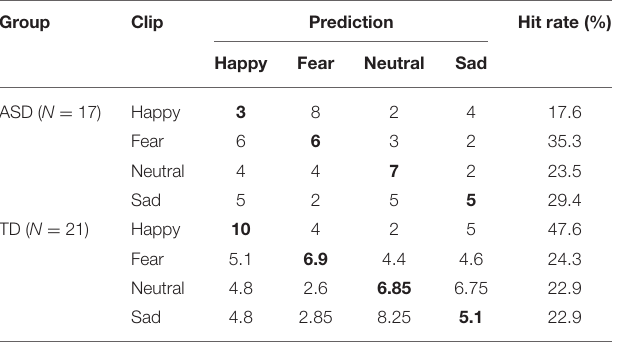
TABLE 6 | Mean cosine similarity between emotional states in each group. Happy